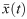
Effects of population heterogeneity on the dynamics of SIR models.Examples for the time course of fraction of susceptible S/N (green), fraction of infected I/N (orange) and fraction of the cumulative number of infected C/N (blue) in a SIR model with N total individuals. (a)-(c) Homogeneous SIR model with R0 = 2.5 and γ = 0.13 day−1. (d)-(f) Heterogeneous SIR model with same R0 and γ and with α = 0.1. (a) and (d) show time course as linear plot, (b) and (e) show semi logarithmic plots of the same variables. (c) and (f) show the normalized time dependent reproduction number R(t)/R0 (yellow) and the average susceptibility x¯(t) (purple) as a function of time. The dotted lines in (a),(b),(d) and (e) indicate the herd immunity level CI. Other parameters: N = 8107 individuals and I0 = 10 initially infected.